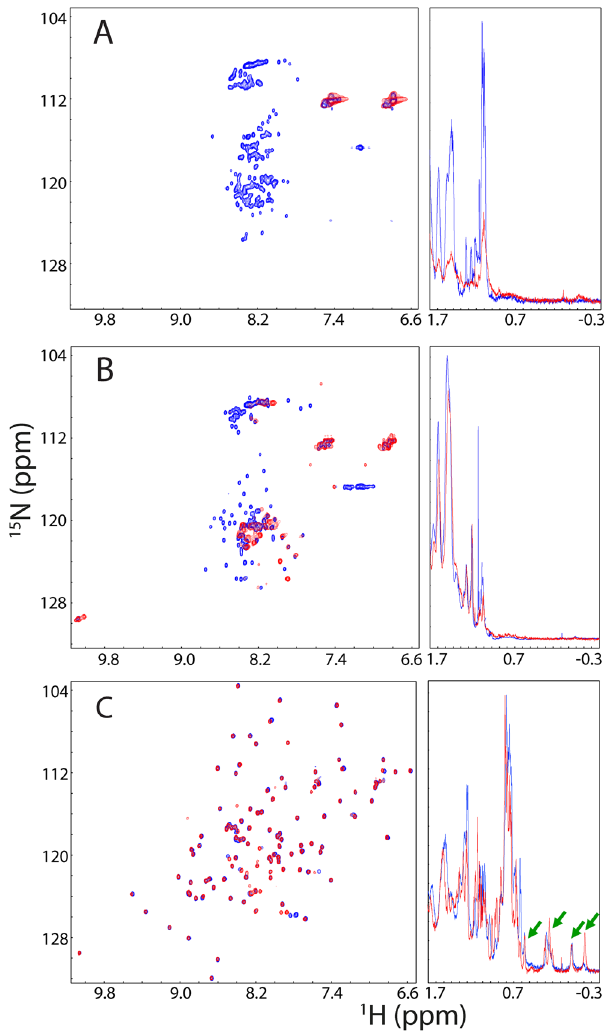
Figure 2. NMR characterization of three dissected domains. Superimposition of two-dimensional (2D) 1 H- 15 N HSQC and one-dimensional (1D) 1 H spectra of the N-terminal LC domain (1–267) ( A ); C-terminal LC domain (371–526) ( B ); and RRM (282–371) ( C ), collected at a protein concentration of 40 µ M at 25 °C in 1 mM phosphate buffer at pH 5.0 (blue) and pH 6.8 (red). The green arrows are used to indicate up-field peaks manifested in 1D spectra characteristic of a well-folded